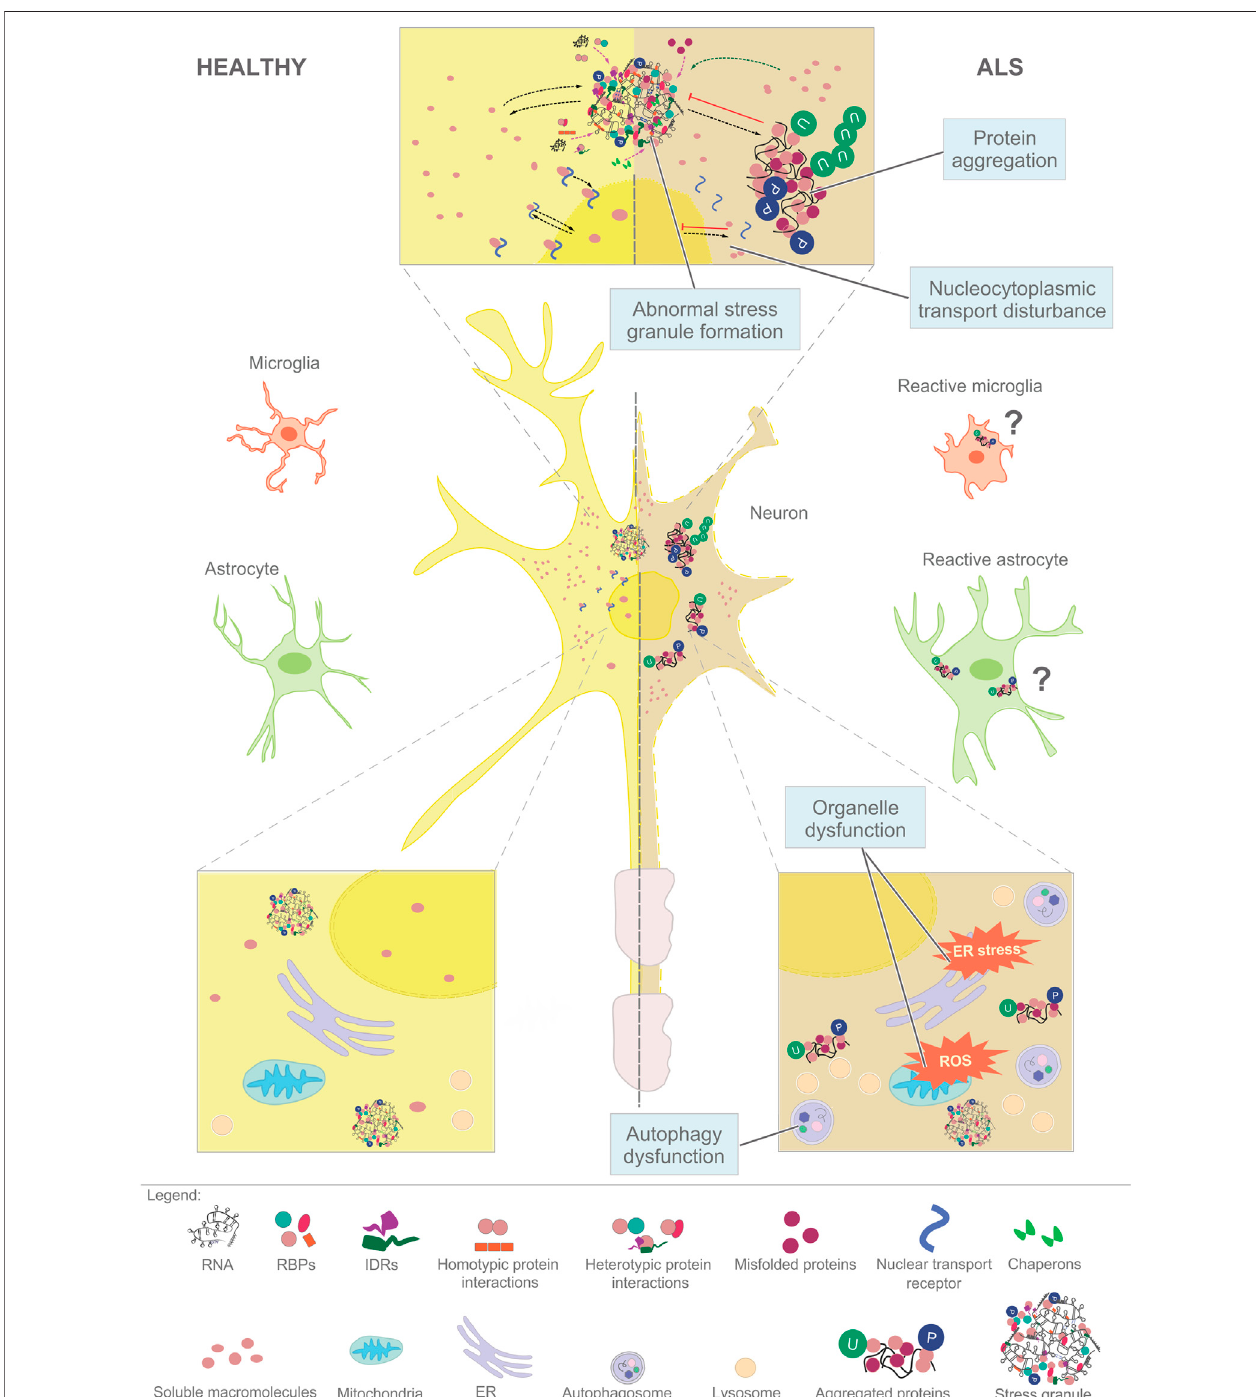
FIGURE 1 | Aberrant phase separation of RNA-binding proteins (RBPs) plays a central role in the cellular pathology of ALS. Macromolecules such as RNAs and proteins assemble in dynamic and reversible condensates in healthy neurons and glia (left), that mature into stress granules (top, center) and insoluble aggregates destined for degradation (right). The cellular pathways that affect the LLPS of RNPs include (i) nucleocytoplasmic transport, (ii) assembly of stress granules, (iii) aggregationdrivenbytheaccumulationofmisfoldedproteins,(iv)organellardysfunctionthatleadstoROSandpersistentstress,and(v)failedautophagy-lysosome pathway. Similar pathways might play a role in glial cells.